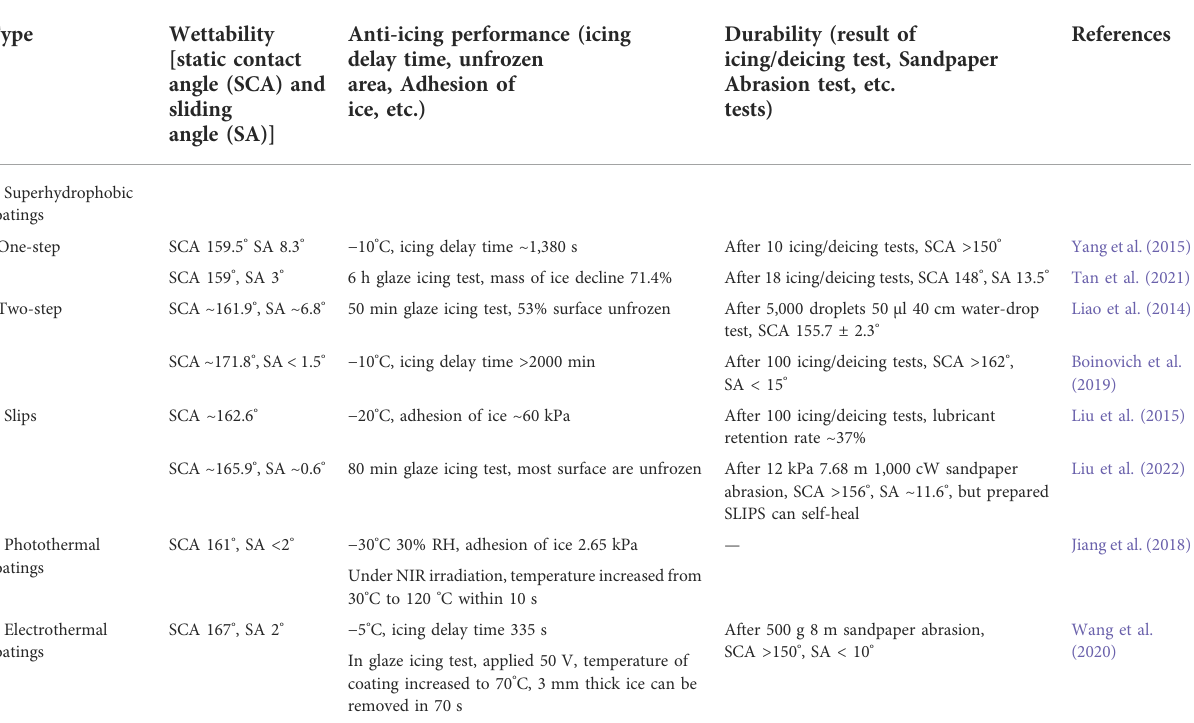
TABLE 2 Performance comparison of typical researches about functional coatings of conductors